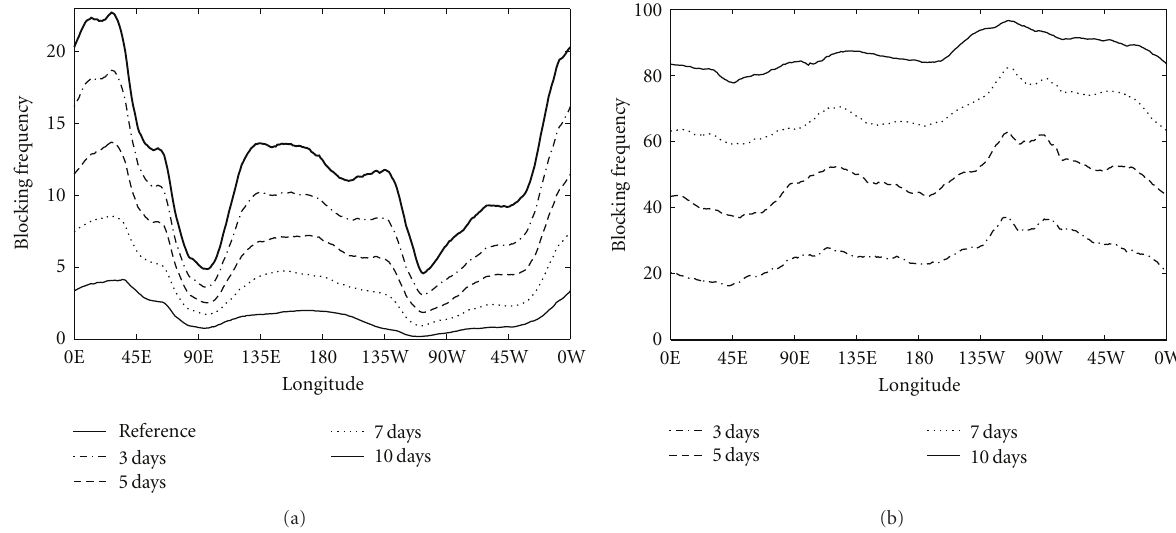
Figure 6: Persistence filter: Northern Hemisphere blocking frequency (a) reference setup and filter thresholds 3, 5, 7, and 10 days and (b) relative changes.